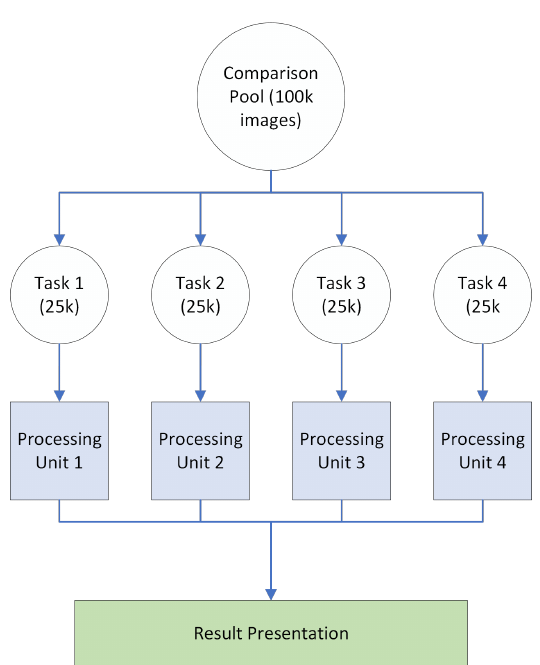
Figure 4. Multi-threaded